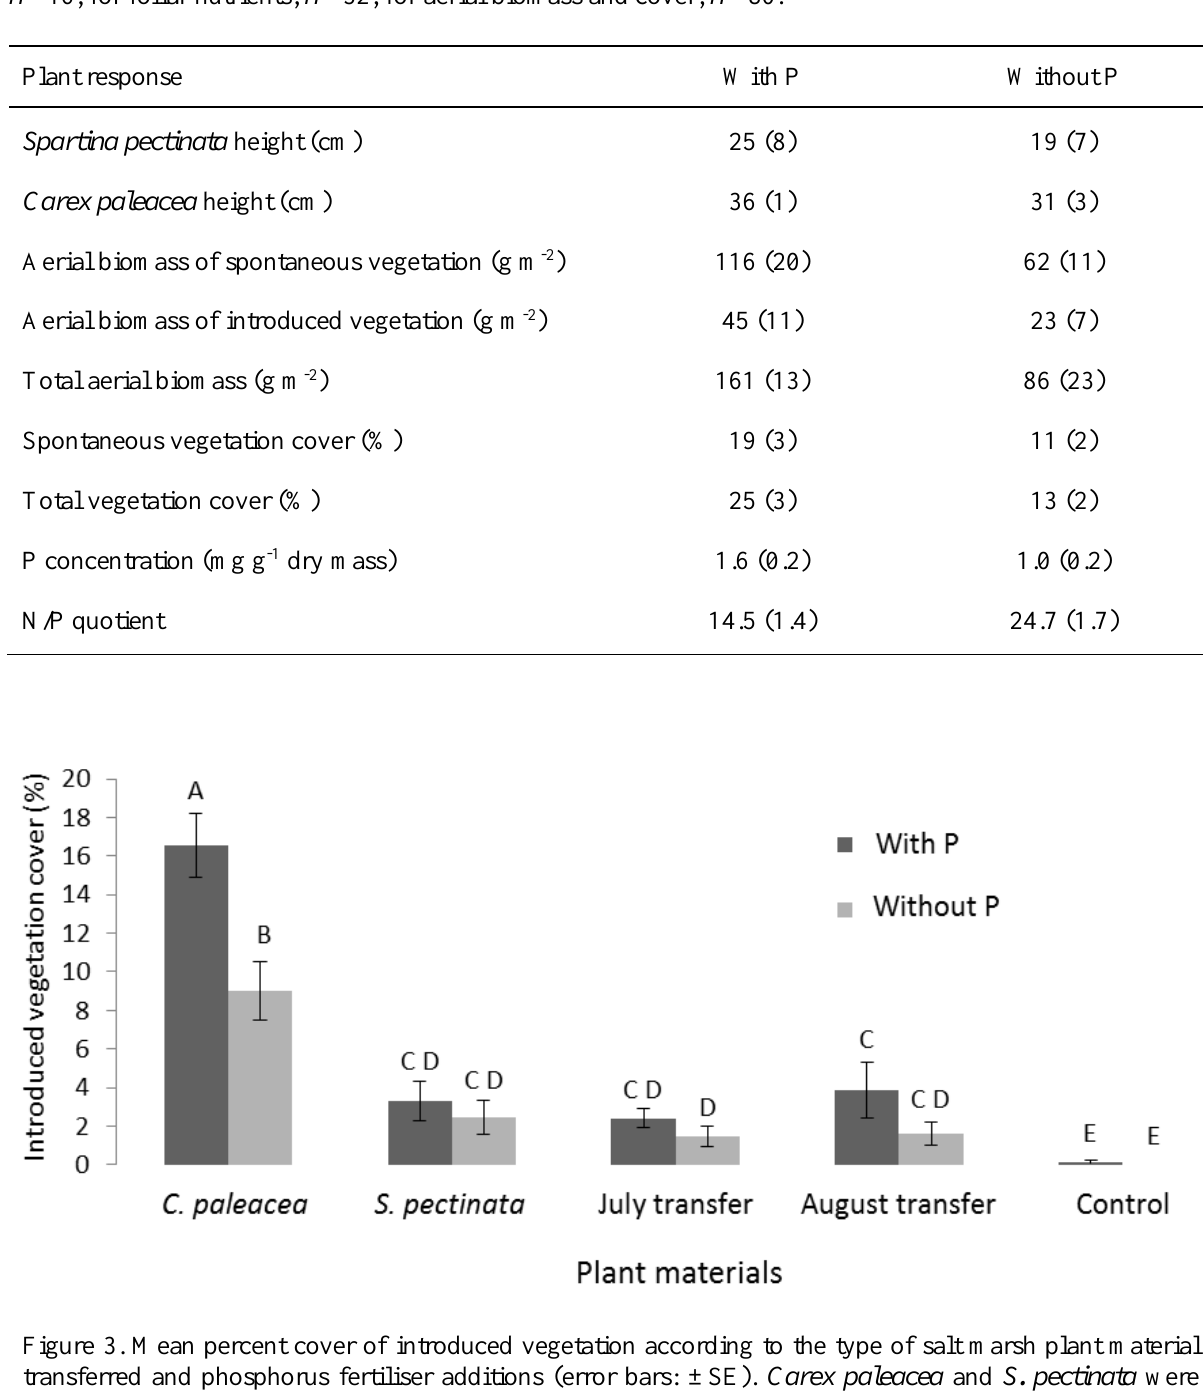
Table 2. The positive effect of P addition on plant height, different types of aerial biomass and vegetation cover, and the mean foliar P concentrations and N/P quotients for C. paleacea and S. pectinata (SE in parentheses). Only variables for which there were significant differences (Table A2) are presented. For height, n = 16; for foliar nutrients, n = 32; for aerial biomass and cover, n = 80.